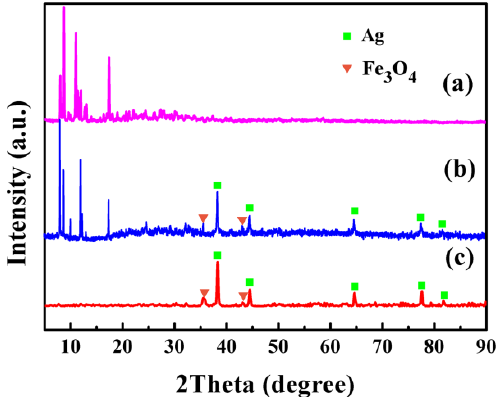
Figure 3. X-ray powder di ff raction (XRD) patterns for ( a ) POMs, ( b ) Fe 3 O 4 / Ag / POMs nanocomposites and ( c ) Fe 3 O 4 / Ag nanoparticles (The di ff raction peak of Ag is represented by squares, and the Fe 3 O 4 is represented by inverted triangles).